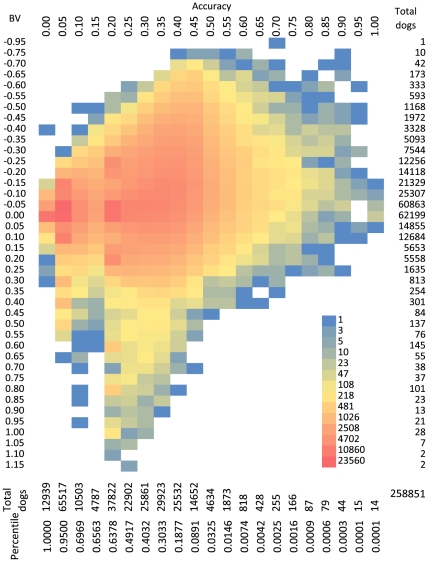
The joint and marginal distribution of breeding value and accuracy.Breeding value (BV) is displayed on the vertical axis and its accuracy is plotted on the horizontal axis for the 258,851 Labrador retrievers born between 1970 and 2005. The marginal distributions of BV and accuracy are indicated by both the total number of dogs and percentile at each category. The dogs on the upper right with lower BV (better hip) and higher accuracy are the most ideal for breeding against hip dysplasia.